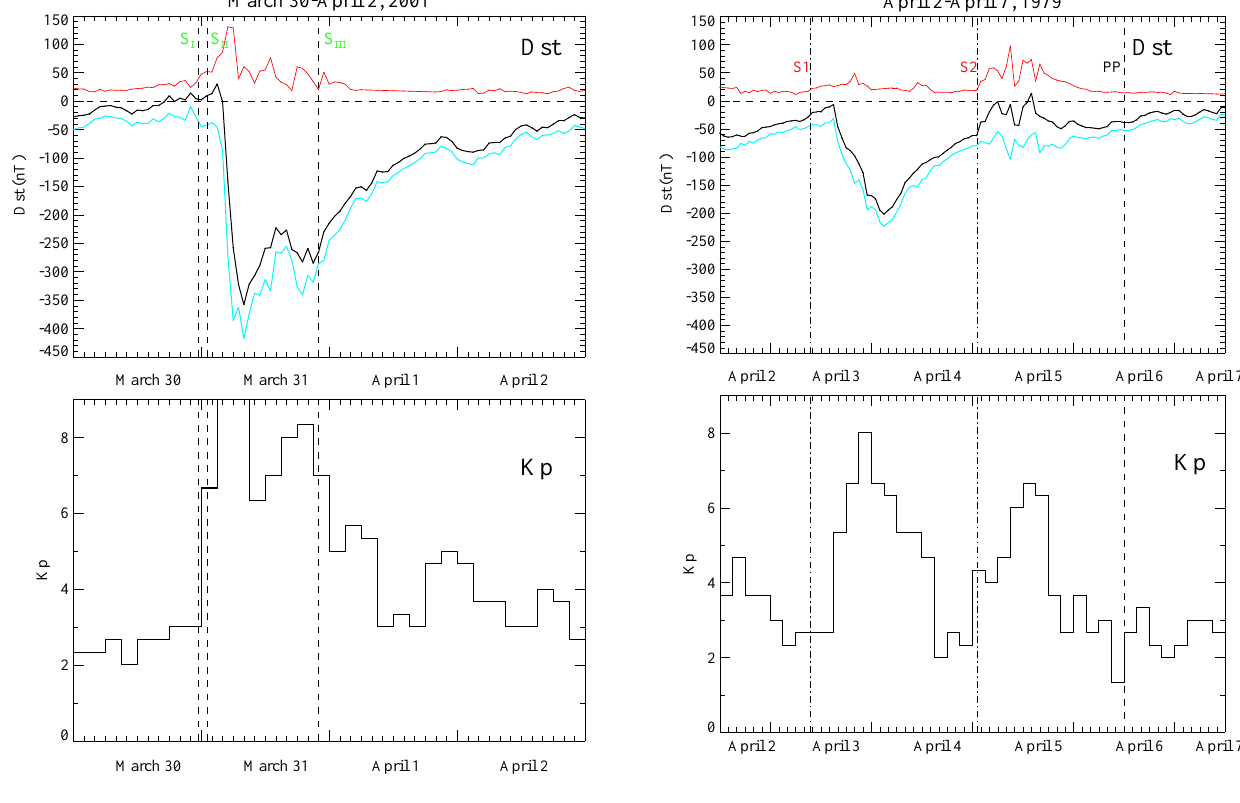
Fig. 12. Similar to Fig. 10, but for the first event sequence. The period plotted is 2–7 April,